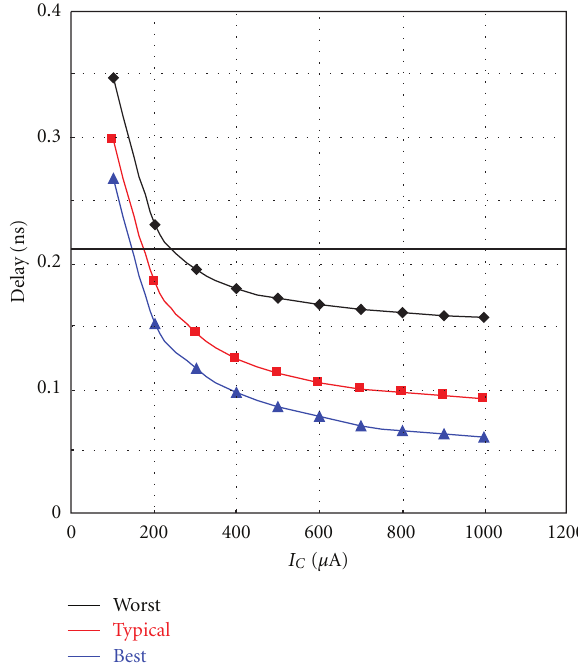
Figure 19: Postlayout simulation results of VCDL delay-current characteristics for DLL2.